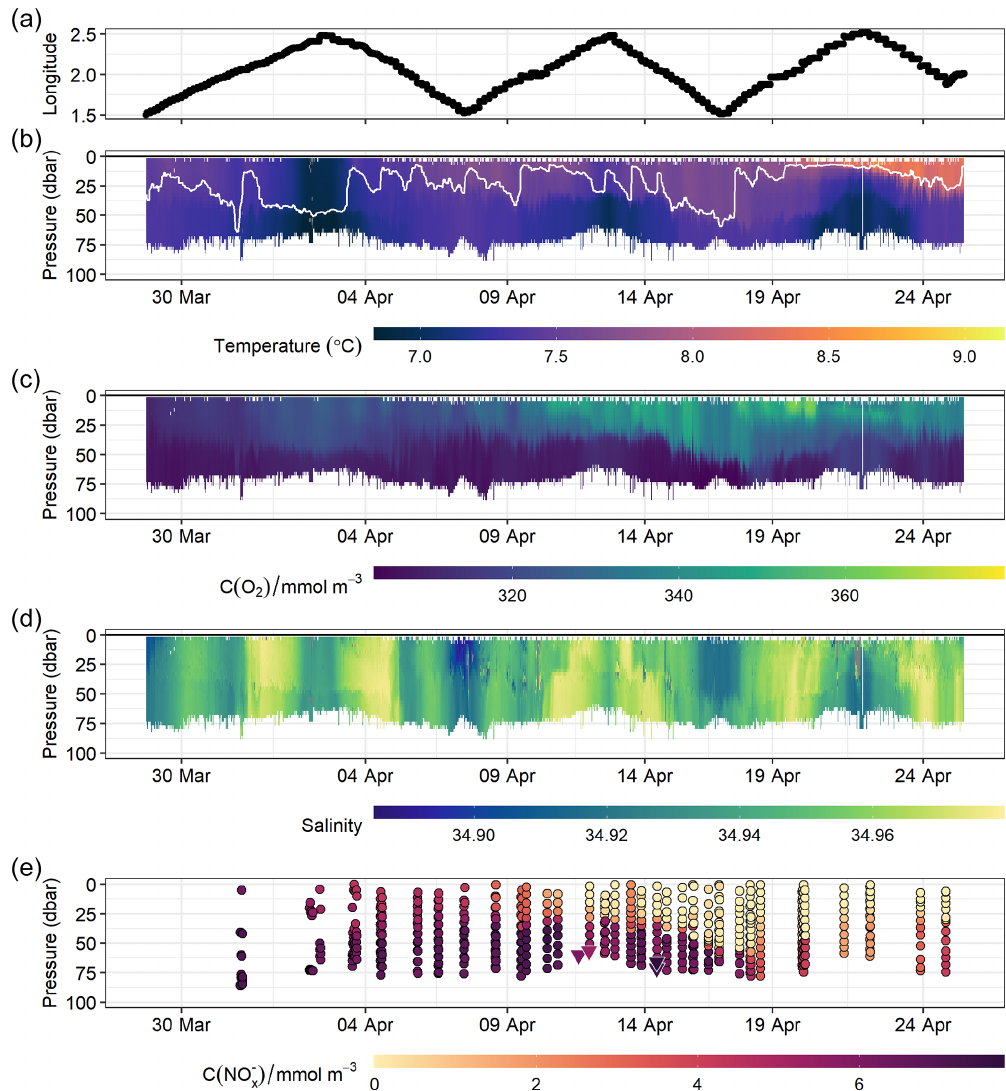
Figure 2. Seaglider location along the transect (a) , with associated temperature (b) and mixed layer depth (green line), oxygen concentra- tion (c) , salinity (d) , and nitrate (e) profiles. Temperature, oxygen, and salinity data are vertically aggregated into 3m bins for each dive. Dark-grey areas indicate data removed though quality control procedures. Samples which are excluded from the NO x − inventory are signified with a green triangle